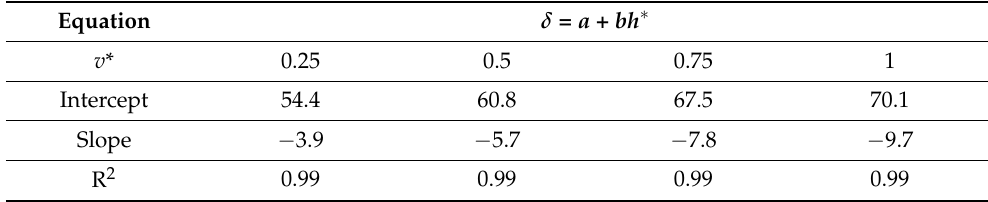
Table 3. Results between δ and v * (when h ≥ 1.4 m ( h * ≥